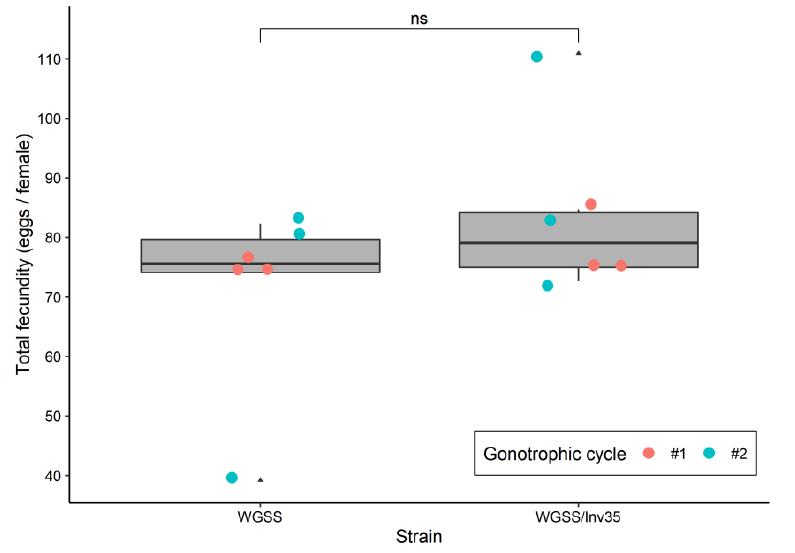
Figure 2. Total fecundity assay (number of eggs per female) of WGSS and the White-eye WGSS/Inv35. Three replicates were performed per gonotrophic cycle per strain. Statistical analysis was carried out using a GLM with Poisson distribution. The whiskers indicate the variability outside the upper and lower quartiles (represented as the upper and lower boxes, respectively). The thick horizontal line represents the median and the triangles indicate a possible outlier. Significance symbol: ‘ns’ for ‘not